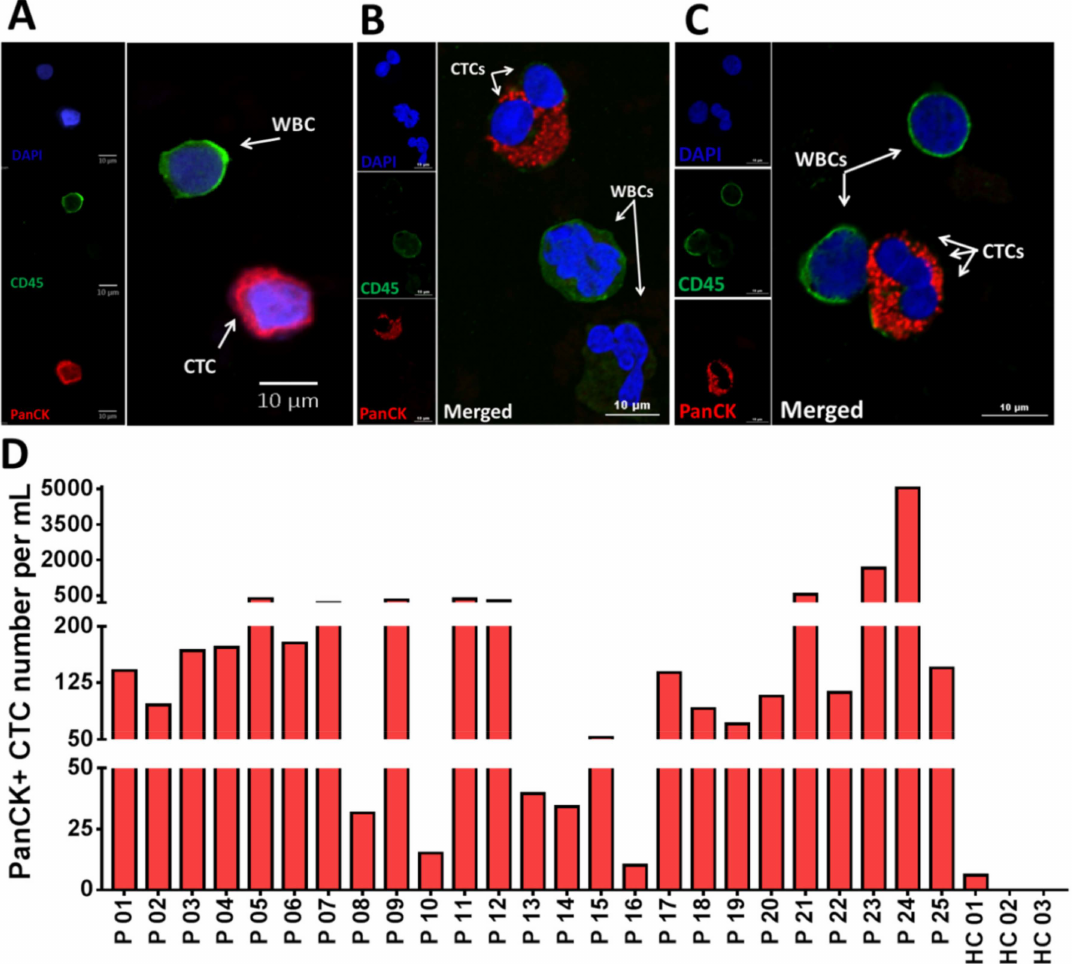
Figure 2. Isolation of circulating tumor cells (CTCs) from non-small-cell lung cancer (NSCLC) patients ( n = 25). ( A ) Fluorescent microscope image of a single CTC. Cells are stained with DAPI (blue), PanCK (red) and CD45 (green). ( B , C ) Confocal microscopy images of some CTC clusters. ( D ) An individual bar plot of the number of CTCs recovered from NSCLC patient samples at baseline, using Labyrinth. The overall number of CTCs in NSCLC patient samples was 417 ± 1023 per mL, while healthy controls had 1 ± 1.7 CTCs per